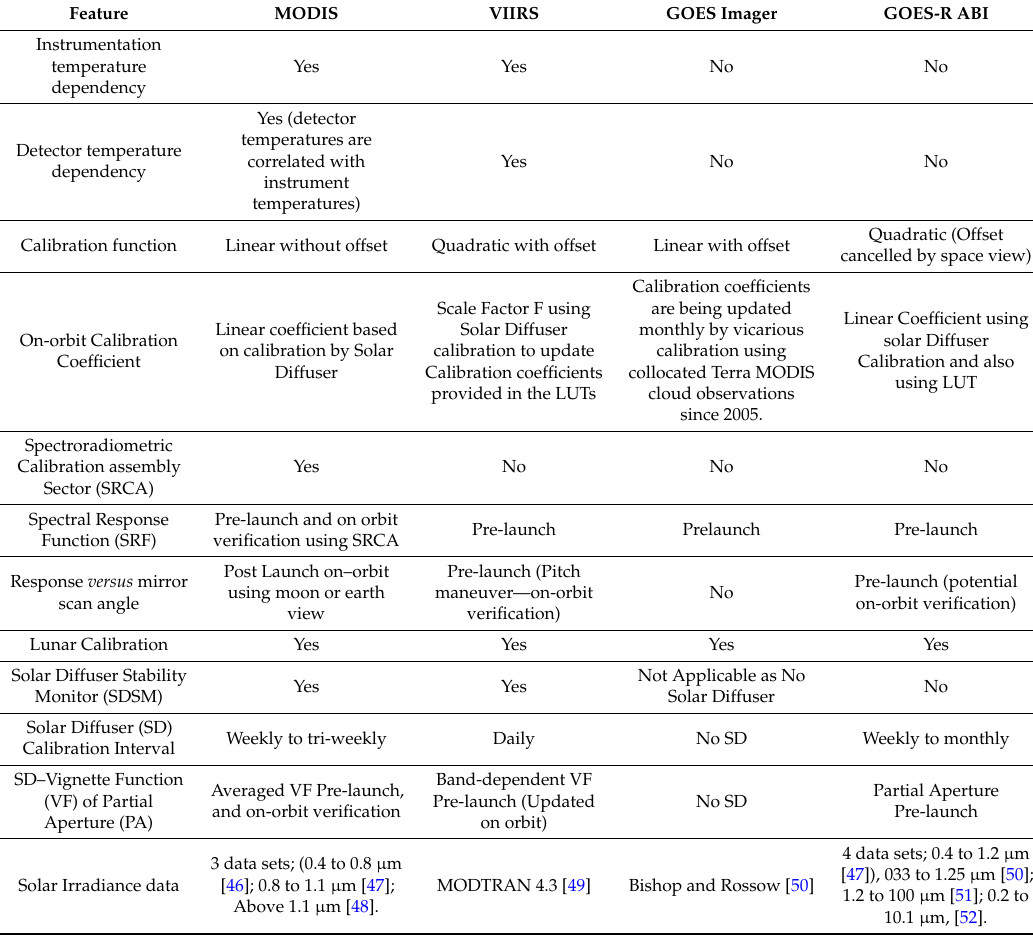
Table 6. Comparison of various features of RSB calibration of the four